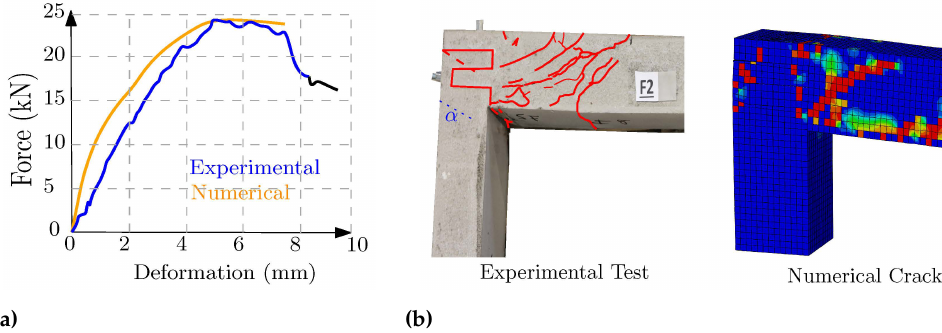
Figure 8. F2, ( a ) Force–deformation, ( b ) experimental cracking and numerical cracking